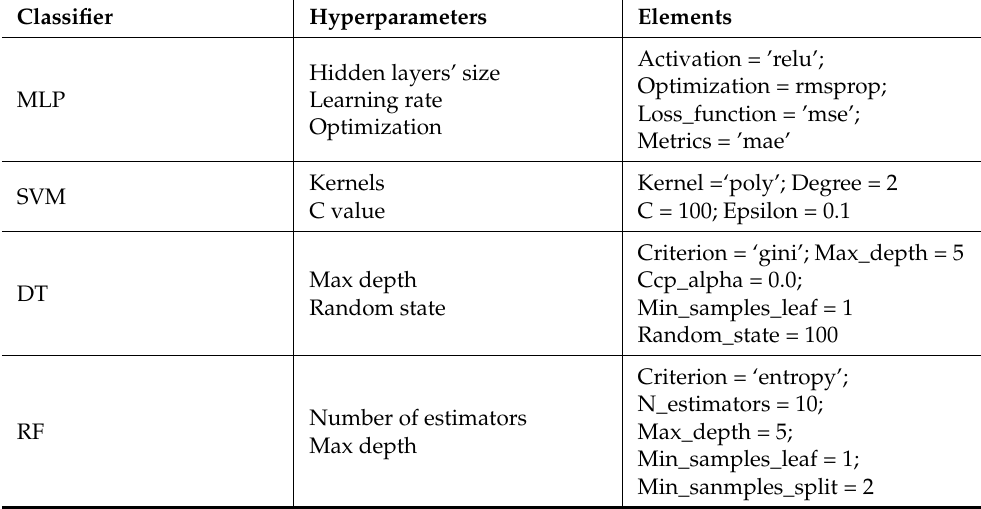
Table 1. The hyperparameters used in the utilized